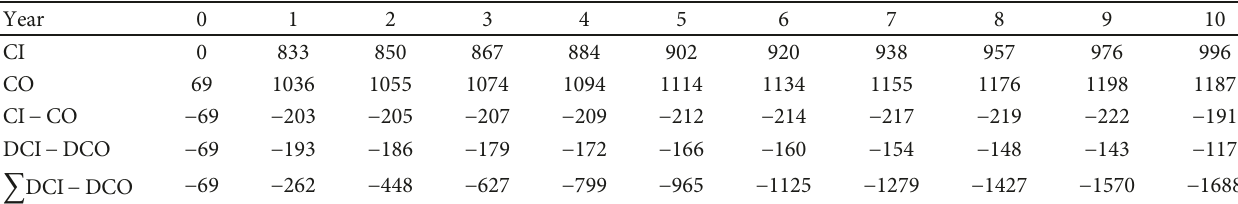
Table 2: Business plan (k €